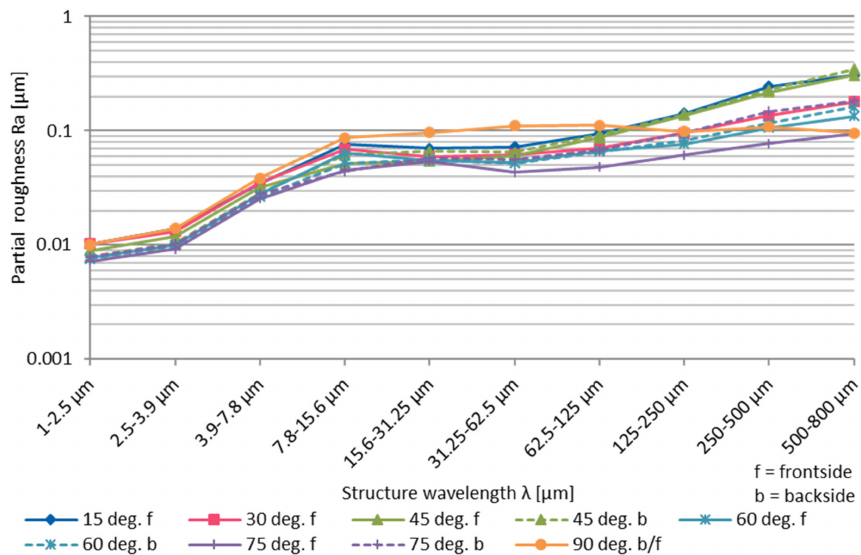
Figure 27. Partial roughness Ra over the structure wavelength λ depending on the fabrication angle α